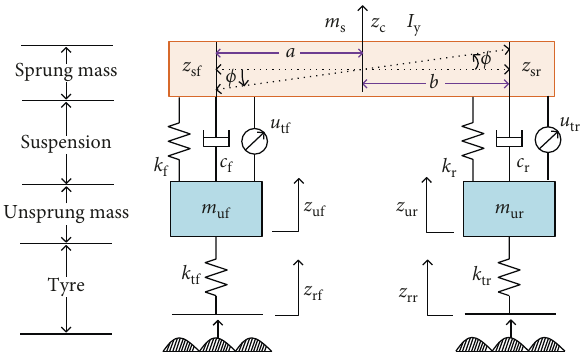
Figure 1: Half-vehicle active suspension